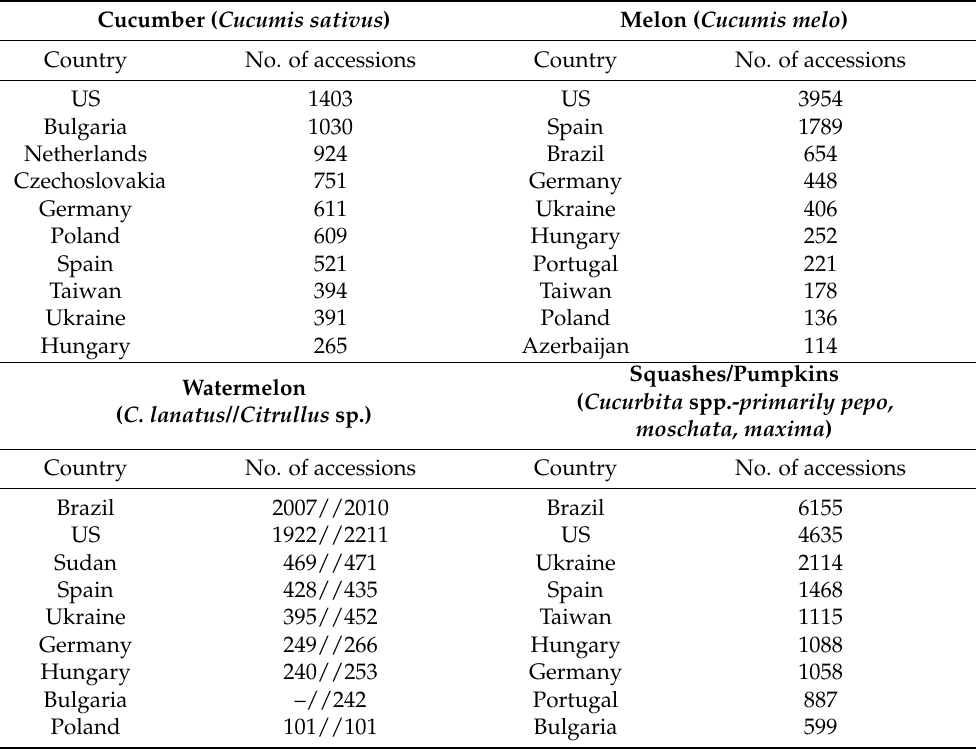
Table 2. The major cucurbit germplasm collections recorded in the GeneSys system (https://www. genesys-pgr.org) [22] 1 (Accessed 25 April 2021). Cucumber ( Cucumis sativus ) Country No. of accessions